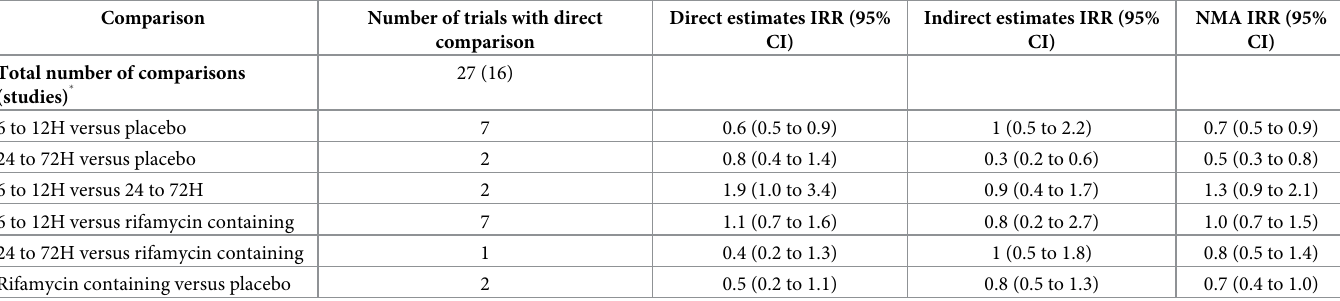
Table 3. NMA of incidence of microbiologically confirmed and clinically diagnosed active TB throughout study duration by aggregated TPT regimens.